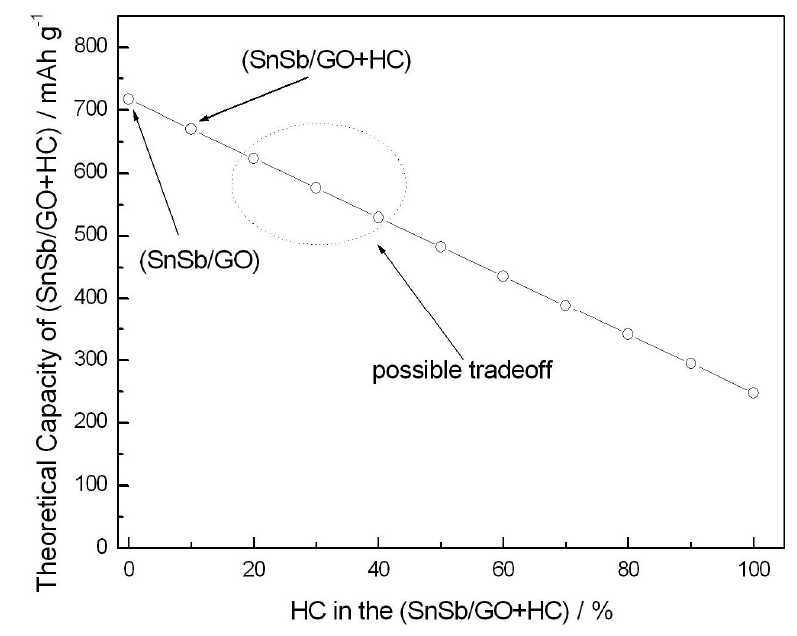
Figure 6. Estimation of the capacity of the (SnSb/GO+HC) composite. Arrows show the compositions tested in this study. Dashed ellipse shows a possible tradeoff between anode capacity and cycle life and coulomb efficiency.